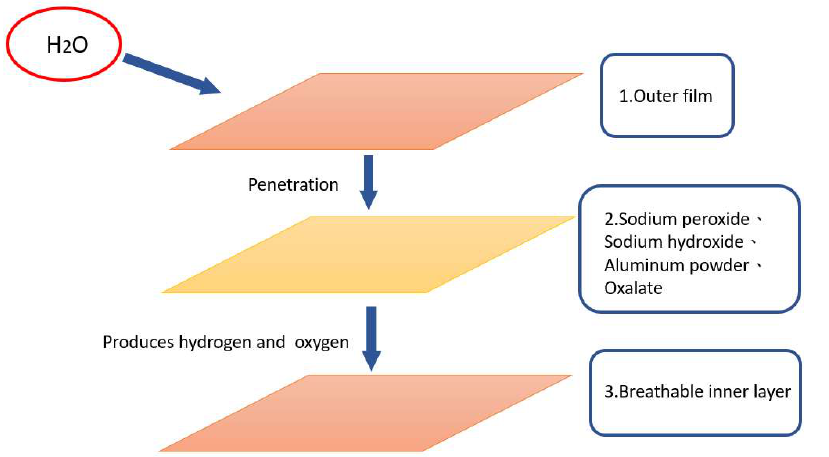
Figure 3. Structure of the functional dressing. The outer film layer has a structure that allows the penetration of H 2 O easily, the middle layer consists of chemical compounds that generate hydrogen and oxygen, and sequentially escape through the inner film